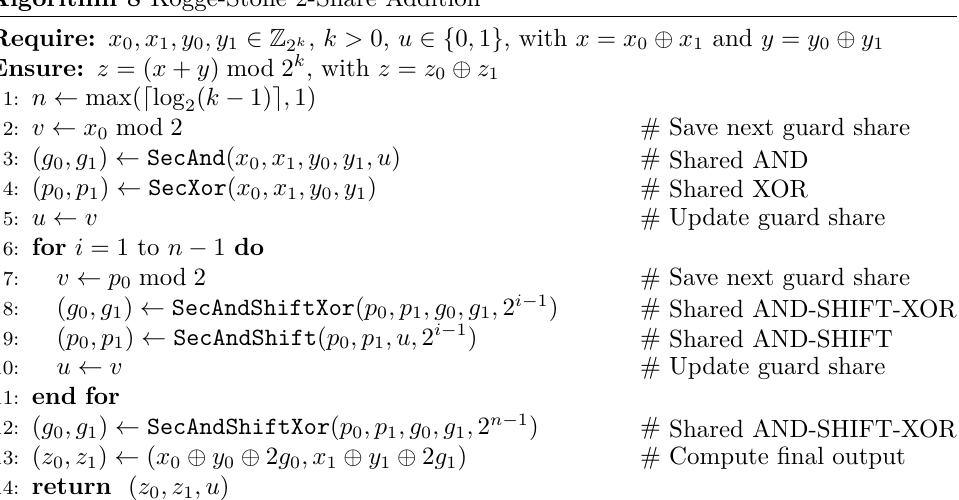
Algorithm 8 Kogge-Stone 2-Share